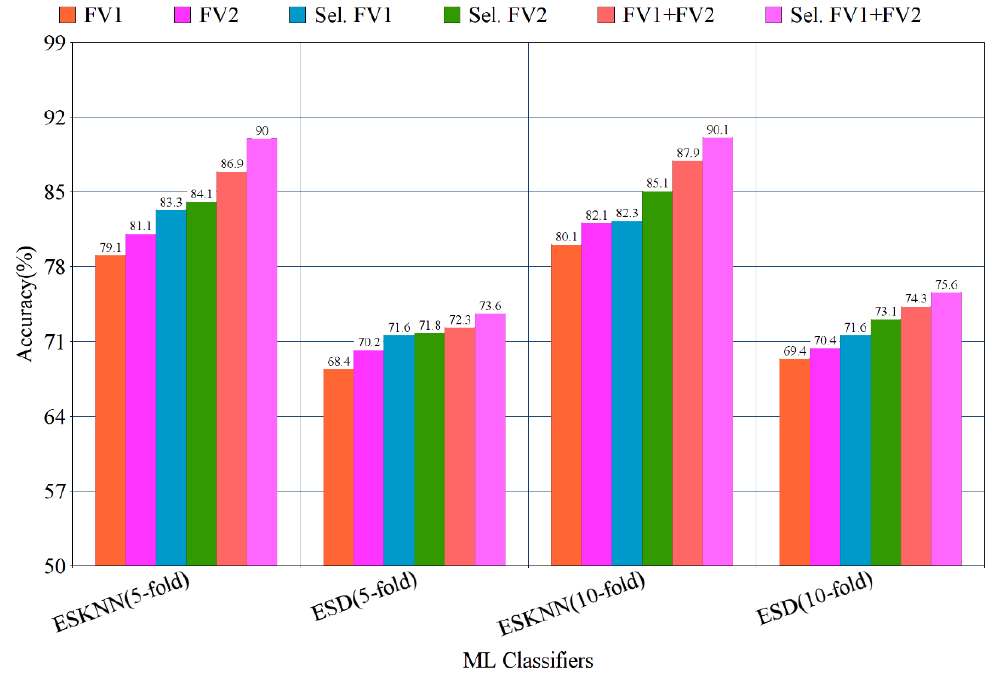
Figure 5. Bar graph representation of results using the proposed method on BreaKHis dataset, with five- and ten-fold validation.